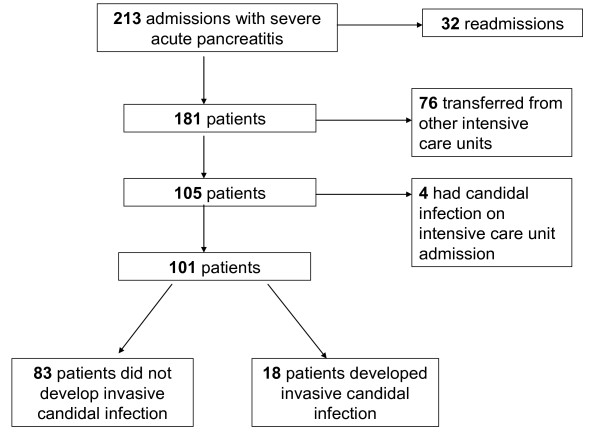
Consort diagram for recruitment of patients.